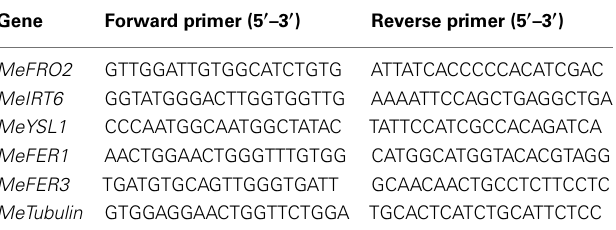
Table 2 | Forward and reverse primers for quantitative PCR (real-time)